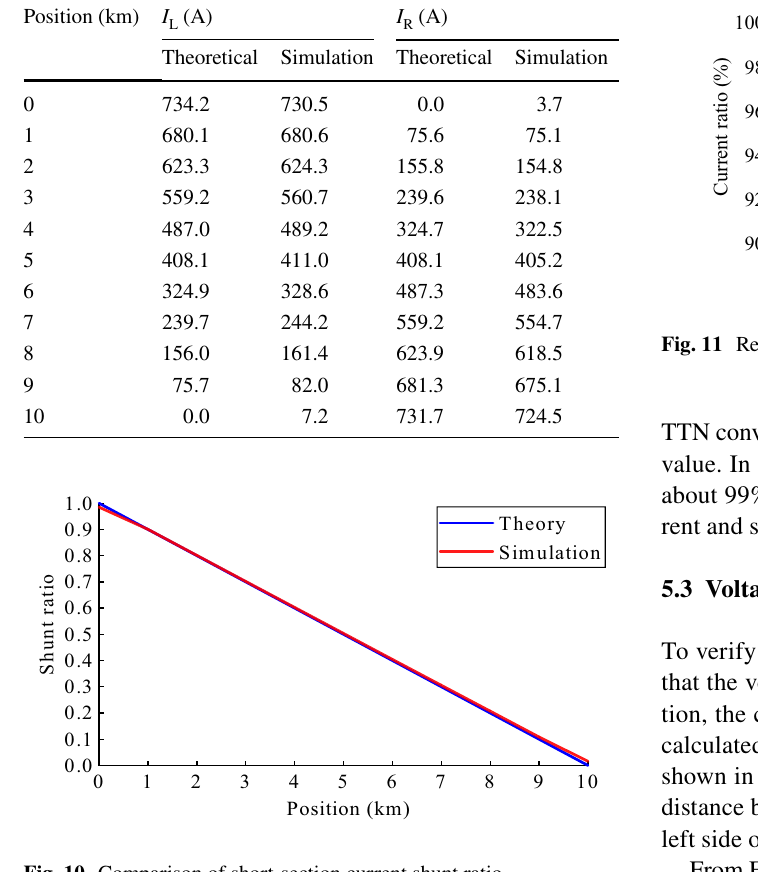
Fig. 10 Comparison of short-section current shunt ratio